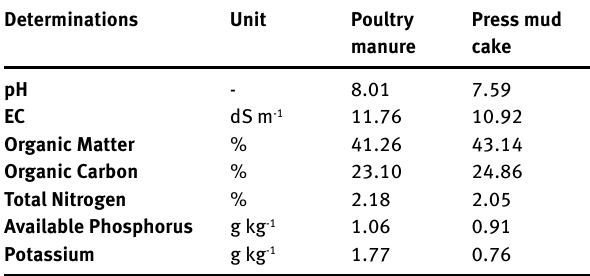
Table 1: Chemical properties of poultry manure and press mud